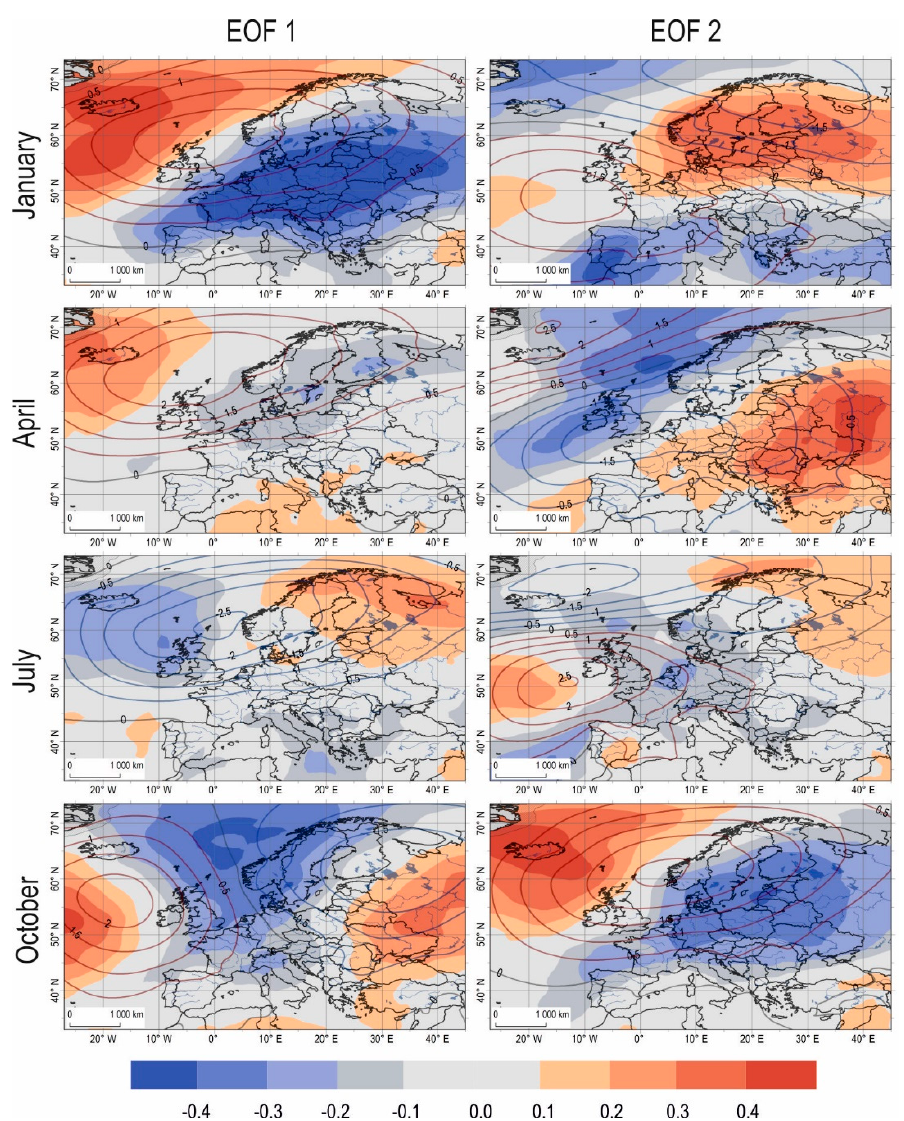
Figure 8. Spatial patterns of SLP anomalies (hPa, solid lines) for two leading EOF modes calculated for days with extremely high moisture content and their relationship with TCWV extremes (Pearson’s correlation coefficient, in color) in selected months (1981–2015).